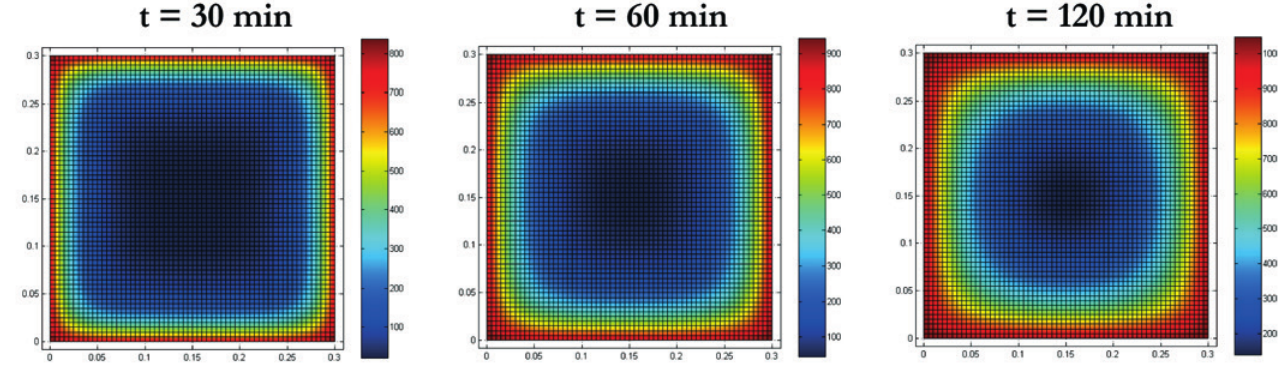
Figure 1 Results of computer program SuperTempcalc [5], for a square cross section 30x30 cm, in some times of fire